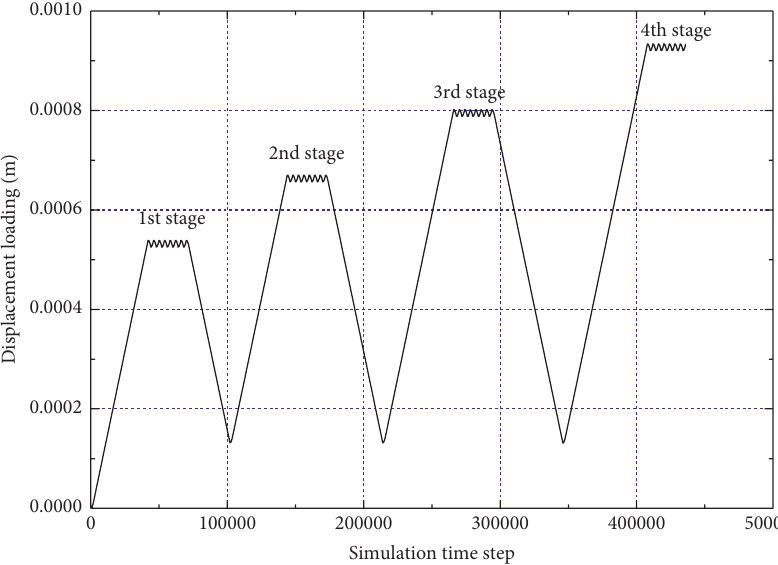
Figure 10: Displacement control in numerical simulation.